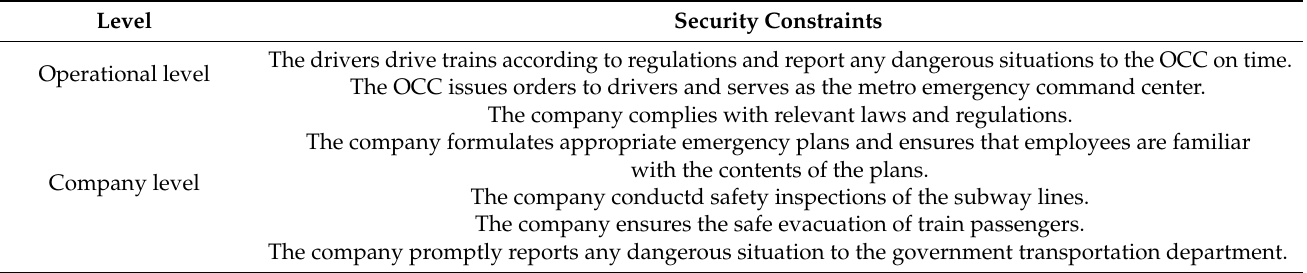
Table 2. The security constraints of various levels.